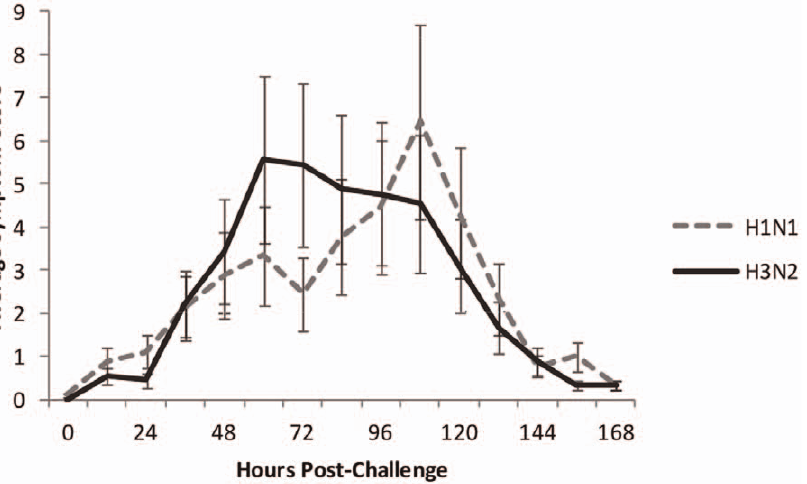
Figure 1. Clinical response to viral challenge. Average symptom scores over time of individuals with both clinical and microbiologically confirmed infection (symptomatic-infected) following experimental viral inoculation with H1N1 (blue) and H3N2 (red).